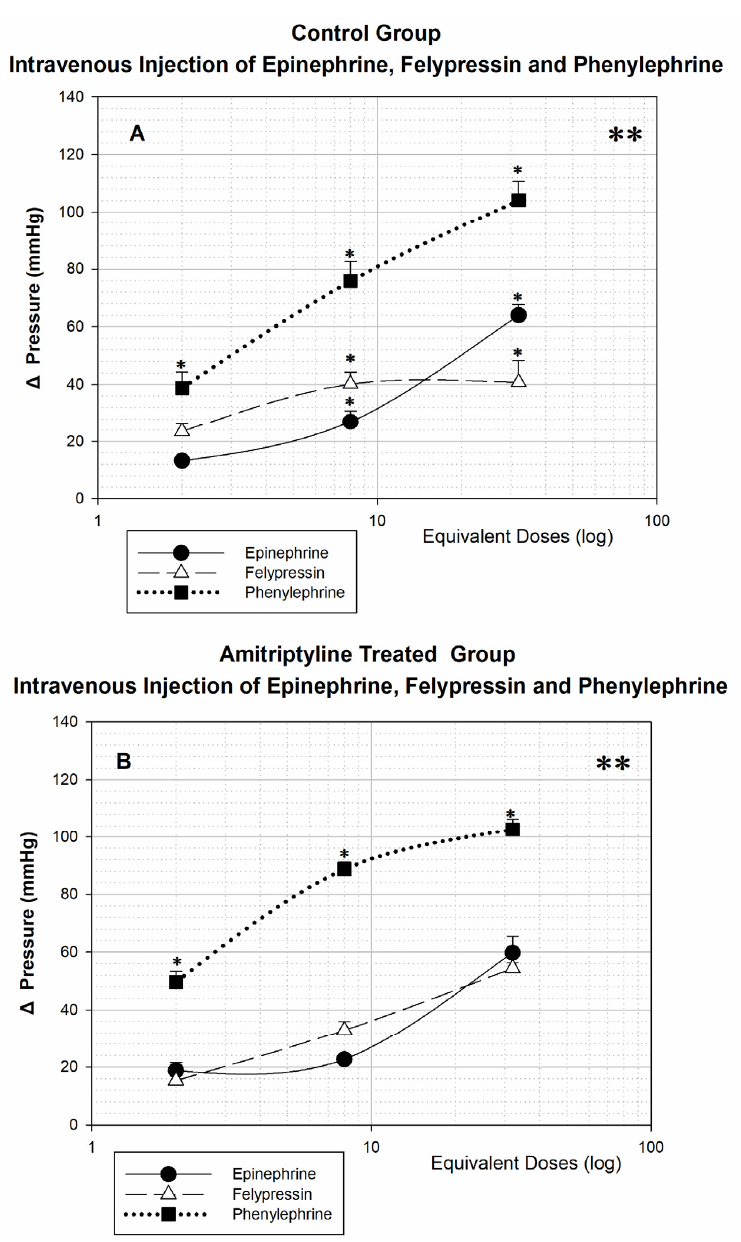
Figure 2. Variation in blood pressure ( ∆ ) produced by intravenous injection of epinephrine, fely- pressin and phenylephrine in rats in the control group ( A ) (n = 7, for each vasoconstrictor) and amitriptyline treated ( B ) (n = 7, for each vasoconstrictor) at equivalent doses to those present in 2, 8 and 32 tubes of local anesthetics with vasoconstrictors adjusted for the average weight of the animals. * p < 0.05; ** p <